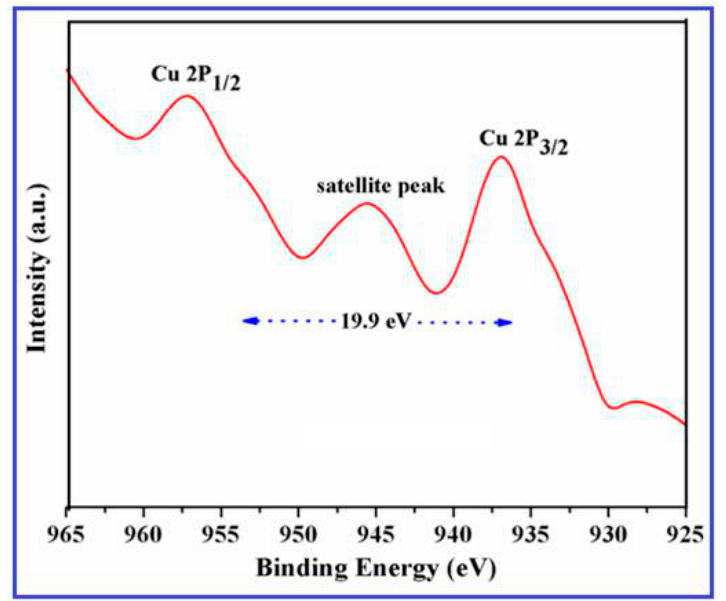
Figure 2. Core level X-Ray Photoelectron Spectrometer (XPS) spectral peaks of CuO nanowires synthesized using Sapindus mukorossi fruit extract (SMFE).